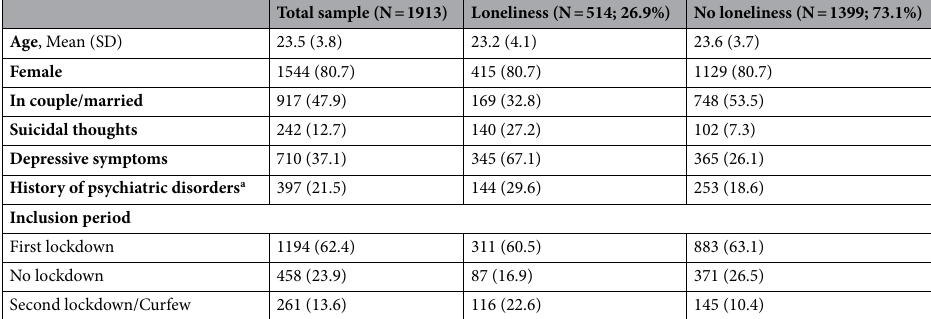
Table 1. Study sample characteristics within the whole sample and according to loneliness. All data presented as n (%), unless otherwise noted. SD standard deviation. a Data missing for 67 participants.